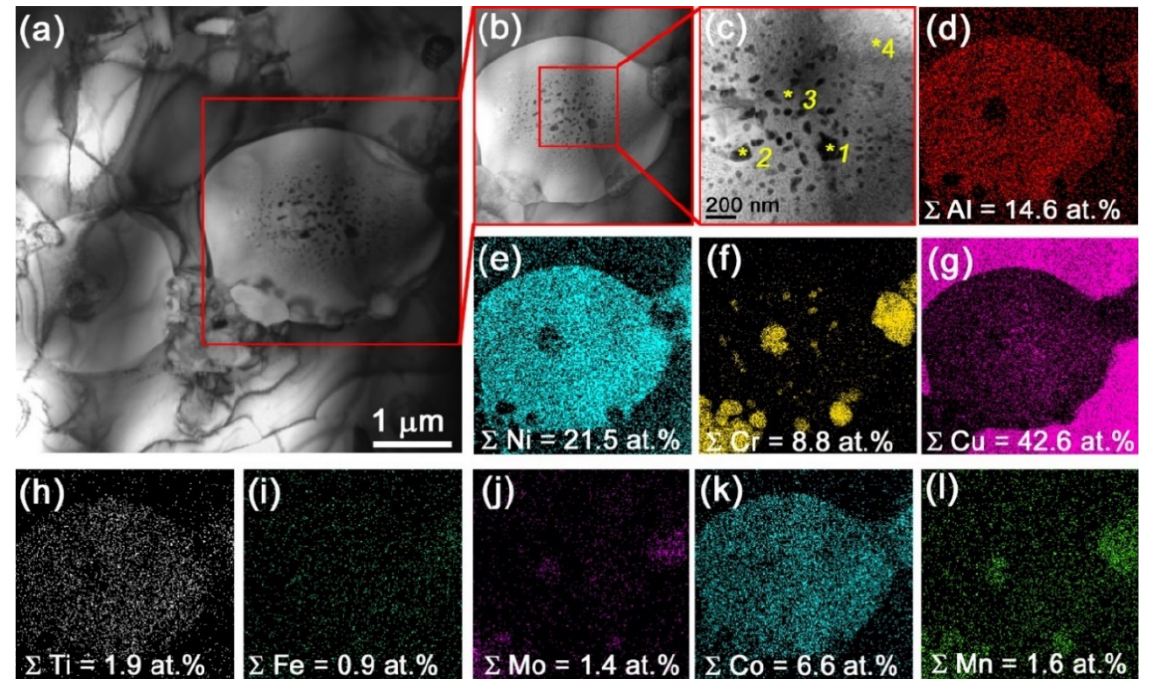
Figure 9. Bright-field TEM image of Ni-rich grains with fine precipitates in 15% Ud composite ( a – c ) and corresponding EDS element distribution maps ( d – l ). EDS element concentrations in zone 1 to 4 in ( c ). Table 2. EDS element concentrations in points indicated on the 15% Ud sample (Figure 9c).